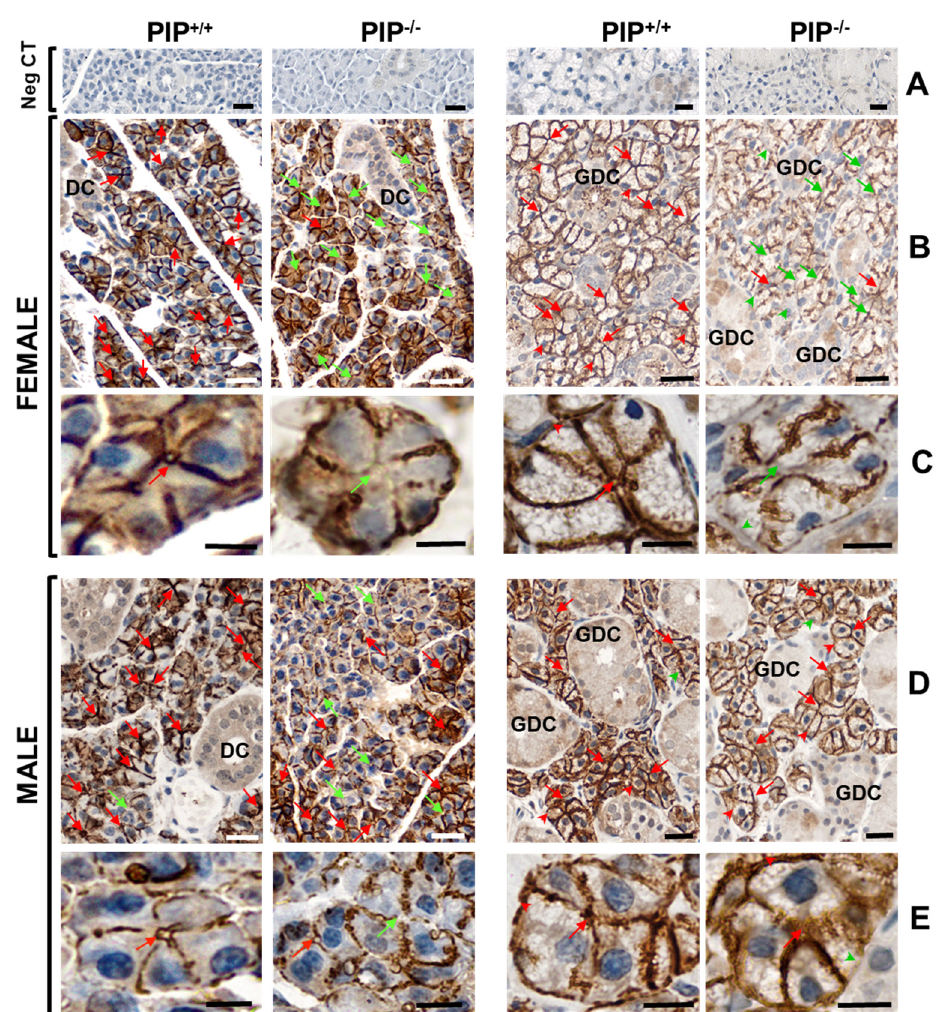
Figure 5. AQP5 localization in P and SM in PIP +/+ and PIP − / − male and female mice. Negative control (Neg CT-up panels) was performed in the absence of a primary antibody. Images are representative of 4 PIP +/+ and 4 PIP − / − male mice for P glands, 5 mice for other groups. Red and green arrows indicate respectively the presence or absence of apical staining in acinar cells. Scale bar: 20 µm (images in horizontal lanes ( A , B , D )) and 10 µm (images in horizontal lanes ( C – E )).